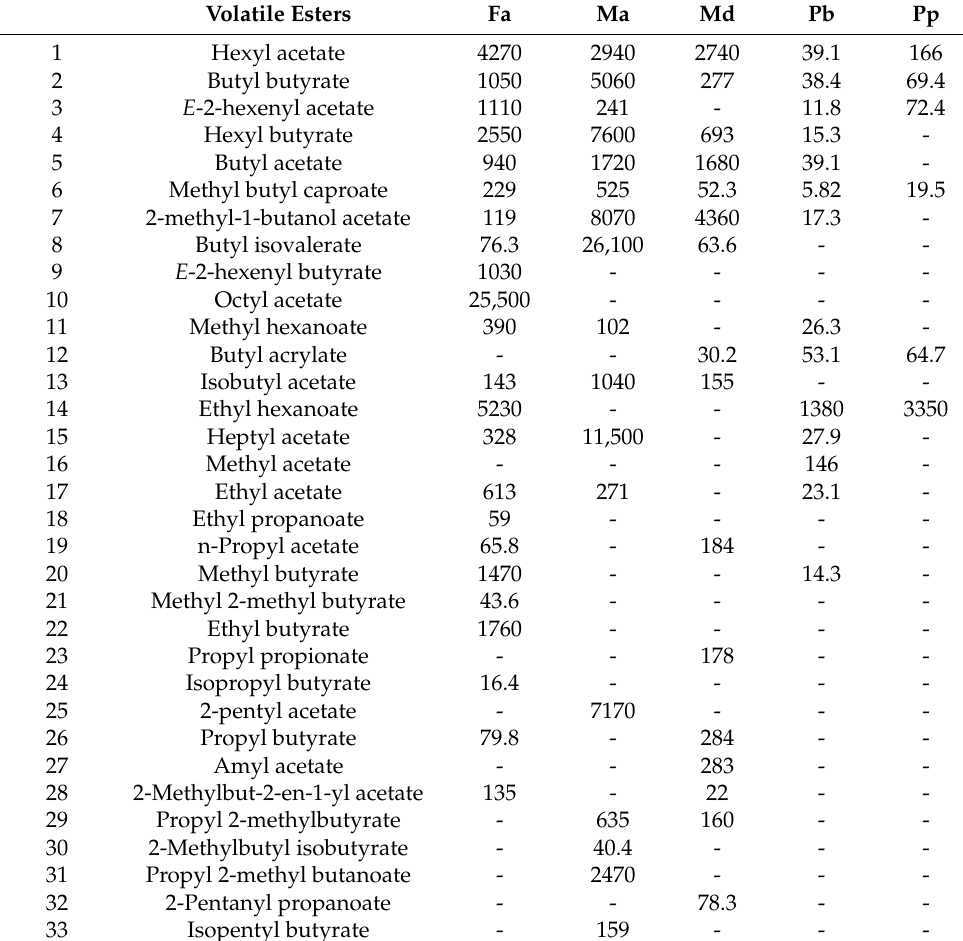
Table 1. Content of volatile ester compounds in five kinds of fruits (ng g − 1